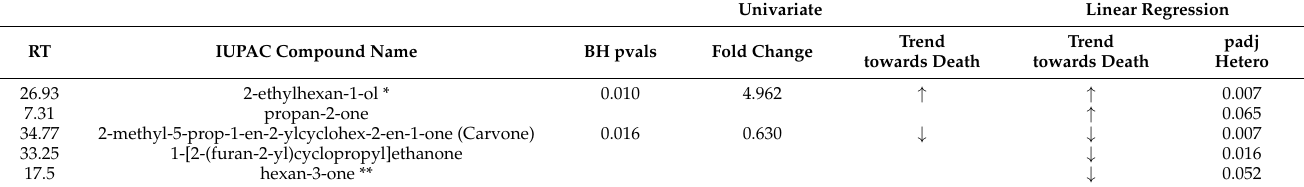
Table 4. Five VOCs shown to change towards death in alkali dataset, using univariate and linear regression analysis. Univariate Linear